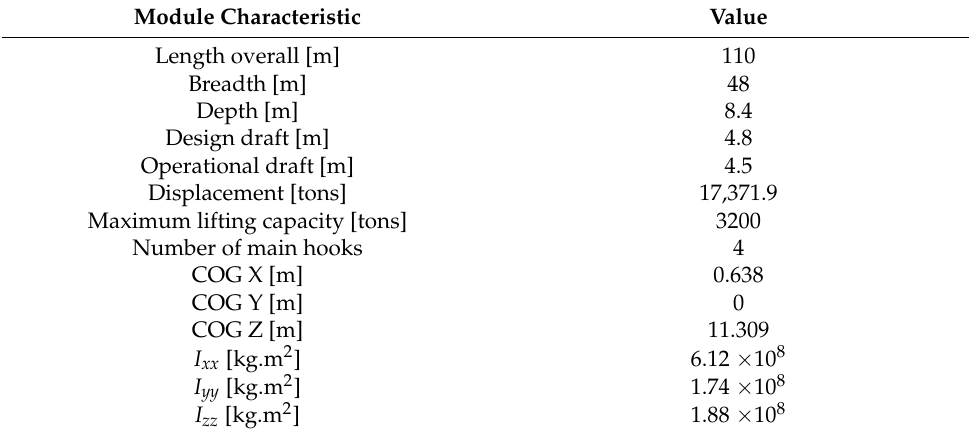
Table 2. Main features of the floating crane vessel.